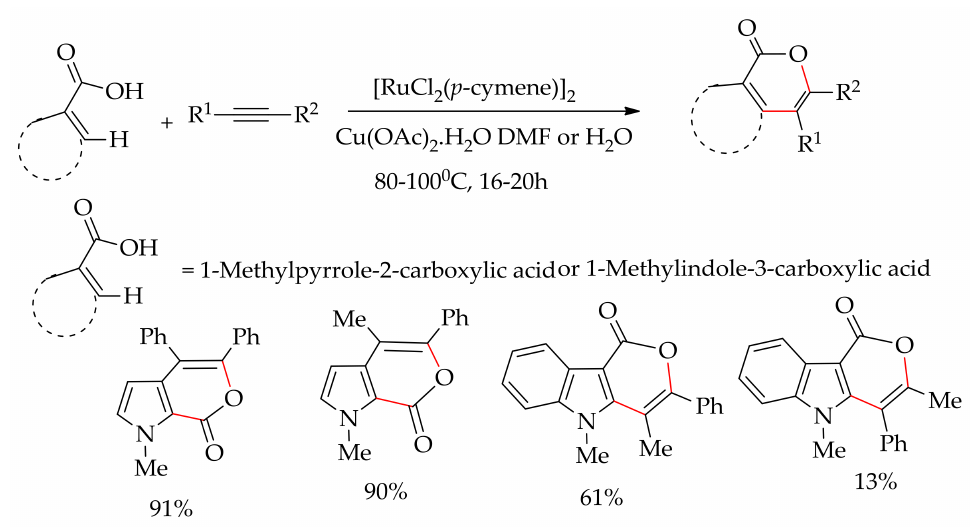
Subsequently, Singh et al. have reported the annulation of N– Heteroaromatic acid derivatives with alkynes using a ruthenium(II) NˆO chelate complex, [RuCl(PySO 3 )( p -cymene)] (Scheme 86) [172]. They found that the efficiency of [RuCl(PySO 3 )( p -cymene)] is comparable to that of [RuCl 2 ( p -cymene)] 2 for the reaction conducted in DMF, but the reaction performed with [RuCl(PySO 3 )( p -cymene)] was not as productive as [RuCl 2 ( p -cymene)] 2 when performed in water.